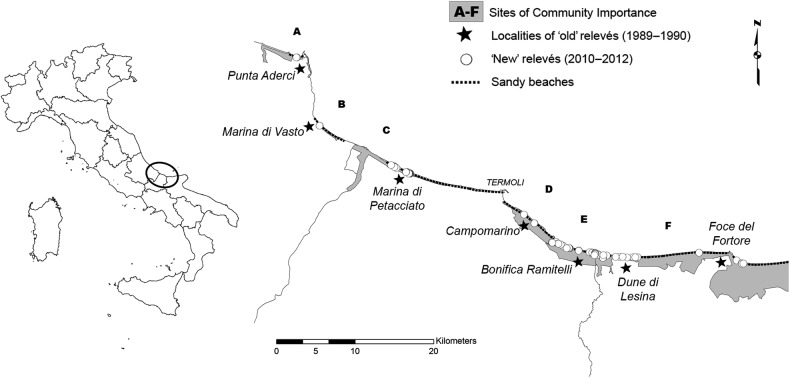
Distribution of the relevés along the coast of the Abruzzo, Molise and Apulia regions. Sites of Community Importance are shown in grey. Black stars identify the sampling localities of relevés conducted in 1989–90, whereas white circles show the relevés conducted in 2010–11. The black dotted line indicates segments of sandy beaches along the shoreline.